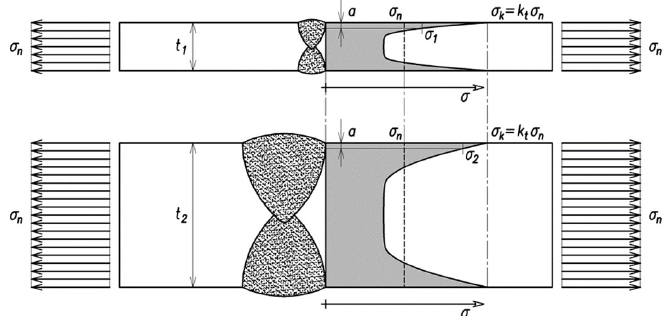
Figure 8. Through-thickness stress gradient in the welded joint [15].